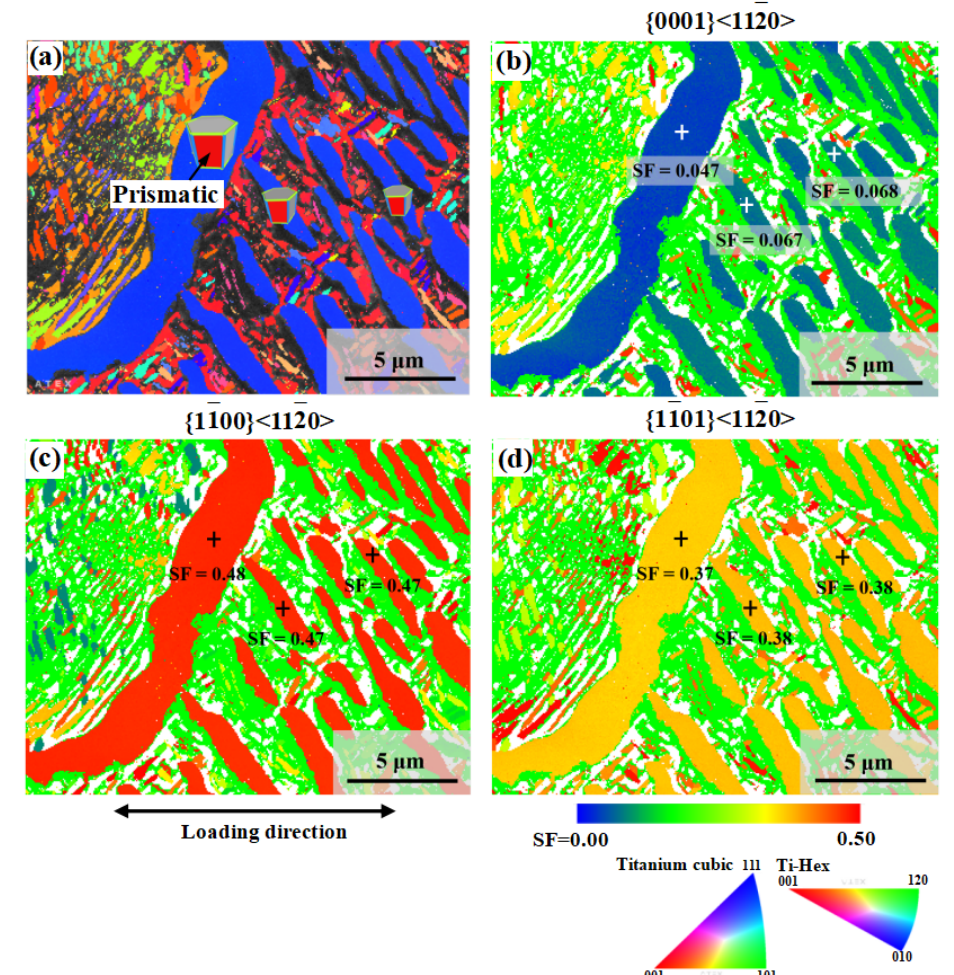
Figure 12. EBSD images of lamellar microstructure after stretching in situ; ( a ) the inverse pole figure map; ( b ) SF map of basal slip for α ; ( c ) SF map of prismatic slip for α ; ( d ) SF map of pyramidal slip for α .